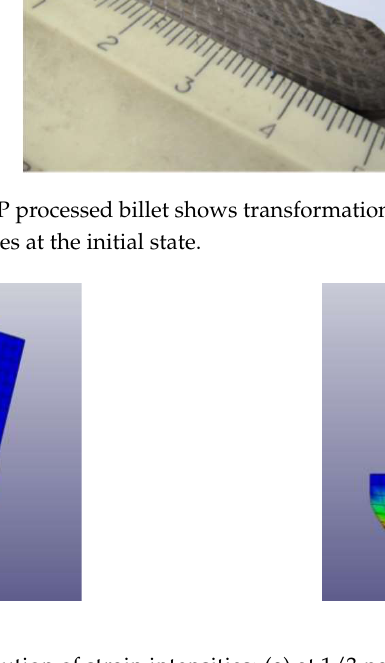
Figure 2. Simulated distribution of strain intensities: ( a ) at 1/3 pass, ( b ) at 3/4 pass of the 1st ECAP pass (relative scales: blue = minimum strain, green = intermediate strain, red = maximum strain).